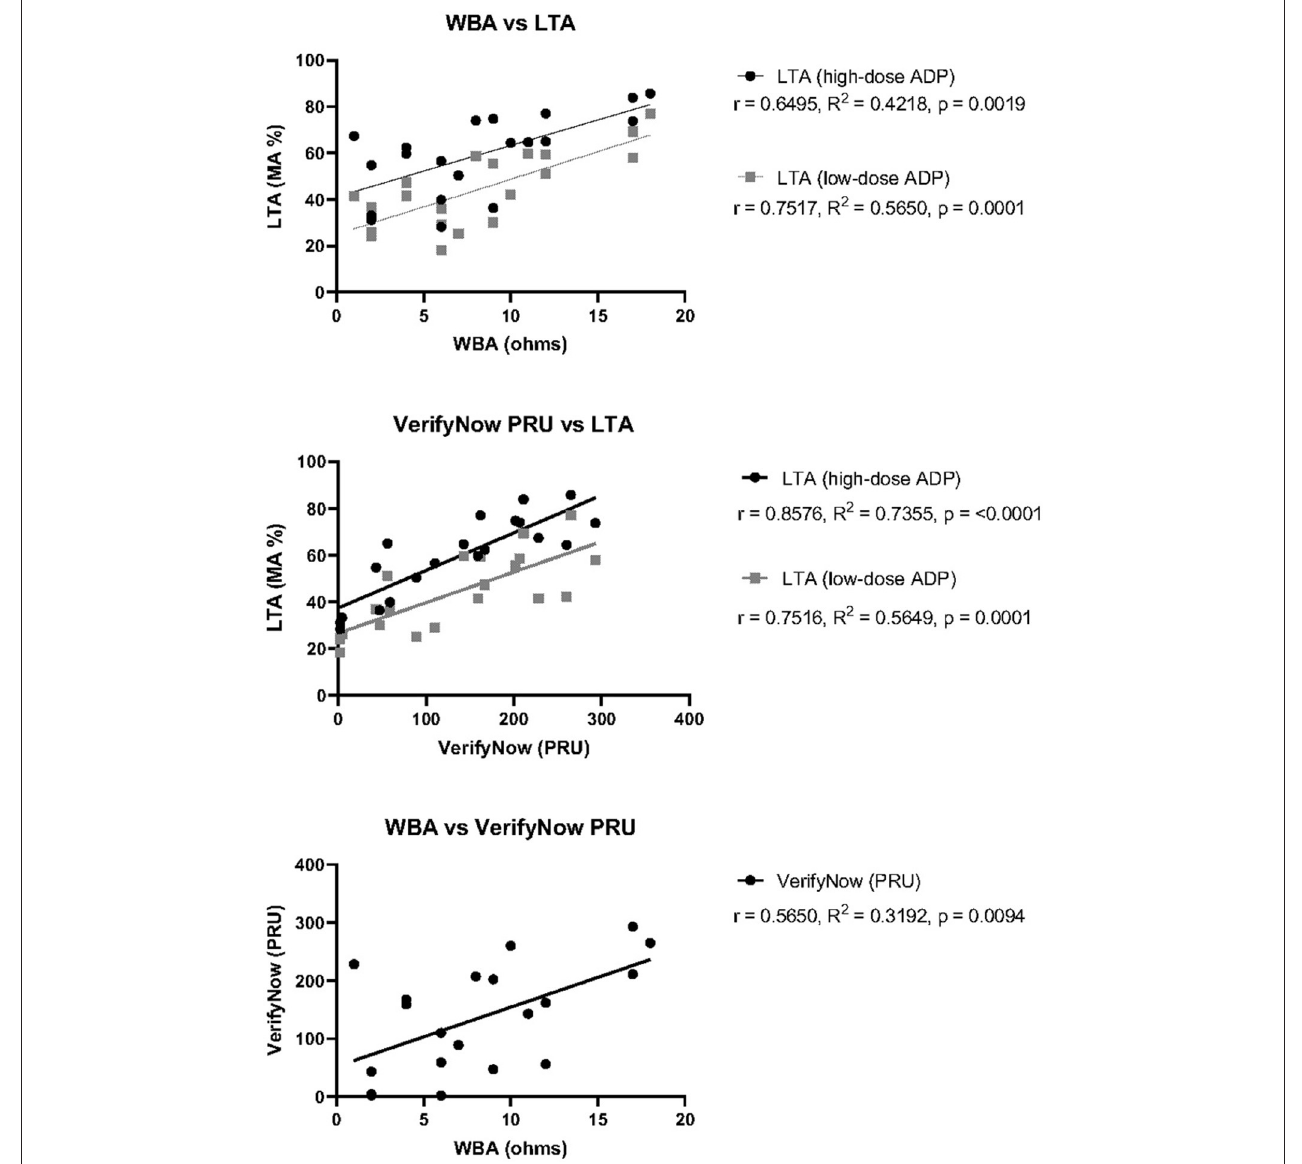
FIGURE 1 | Correlation of P2Y12-I response test measurements between three test platforms. Pearson’s correlation coefficient (r), goodness of fit by simple linear regression (R 2 ), and statistical significance (p) was calculated for each pair of tests using the raw measurement values obtained for each patient. Top: WBA against either LTA with high-dose ADP (black) or low- dose ADP (gray). Middle: VerifyNow PRU Test against either LTA with high-dose ADP (black) or low-dose ADP (gray). Bottom: WBA against VerifyNow PRU